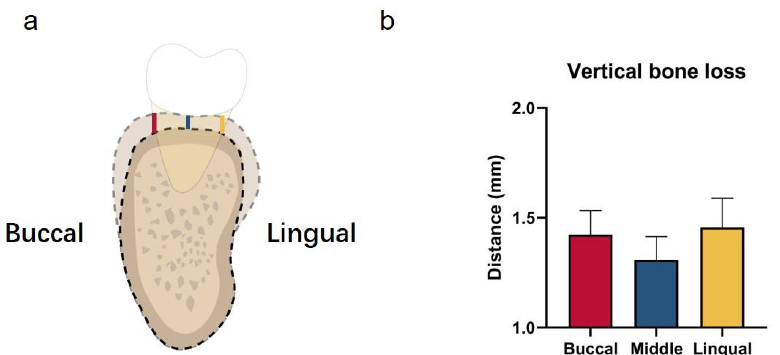
Figure 6. ( a ) Illustration showing the measurements of vertical alveolar bone loss on buccal, middle, and lingual sides. ( b ) Vertical bone loss on buccal, middle, and lingual sides.